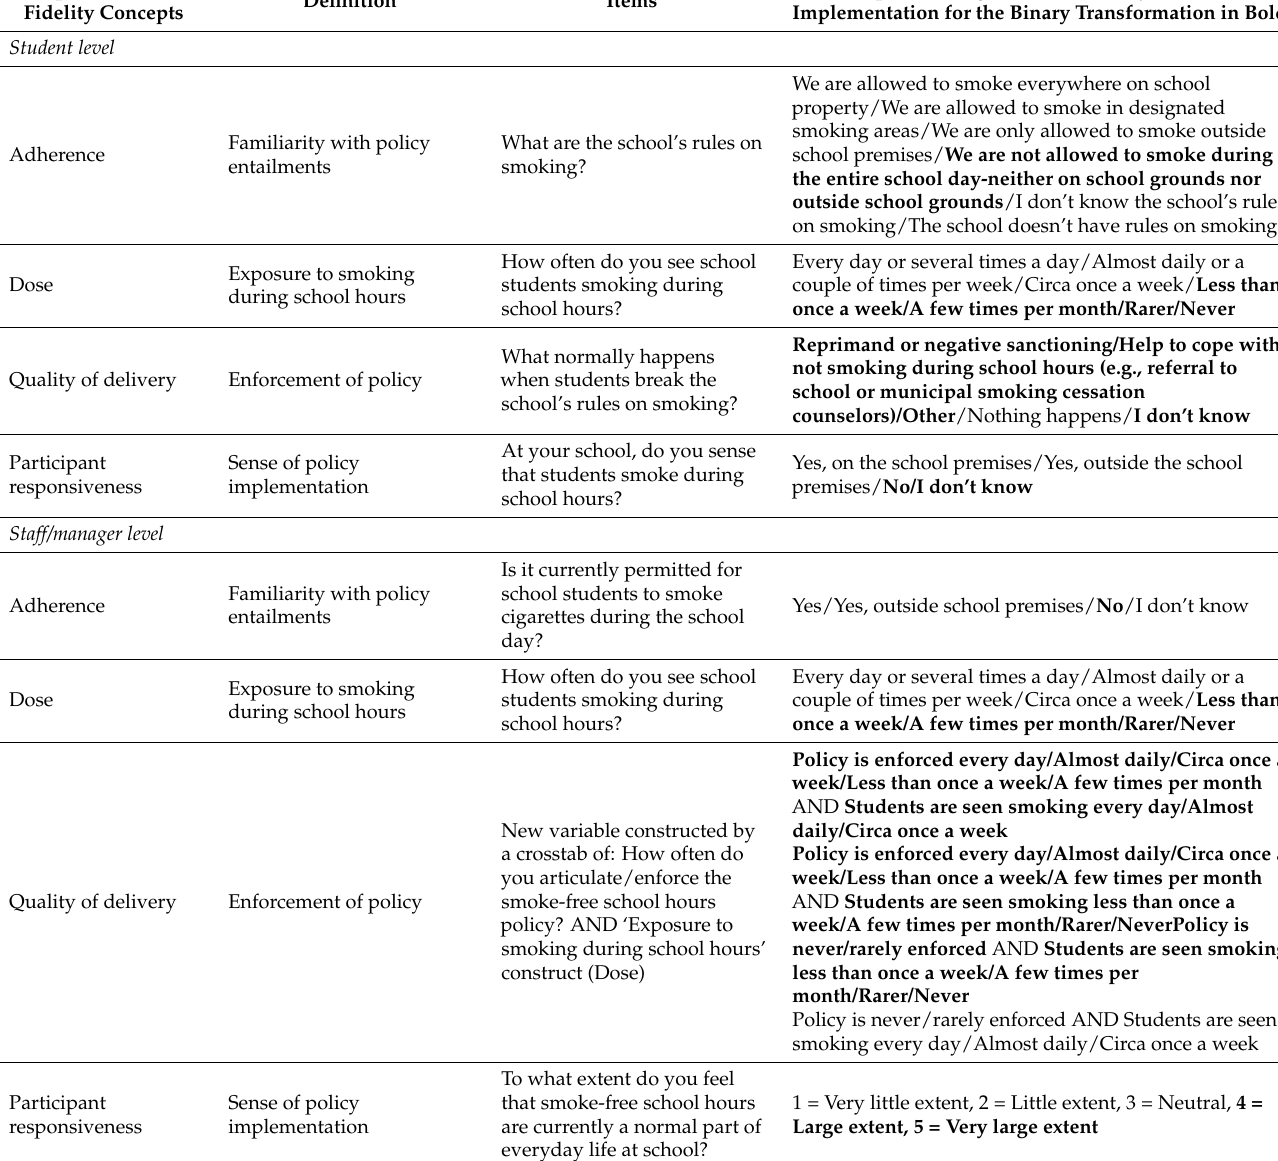
Table 2. Implementation fidelity outcome measures—student level and staff/manager